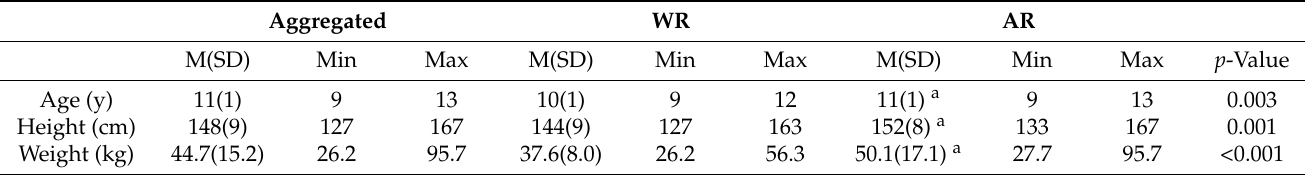
Table 1. Descriptive statistics of all participants ( n = 63) and by league (WR: n = 27 and AR: n = 36).